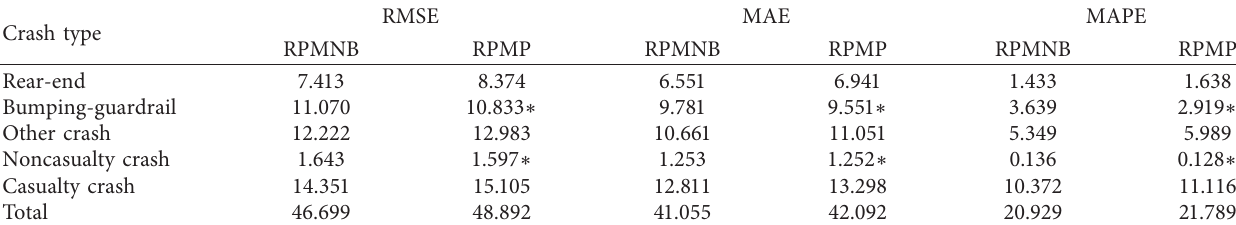
Table 6: Predictive performance measure of two models (RPMNB and